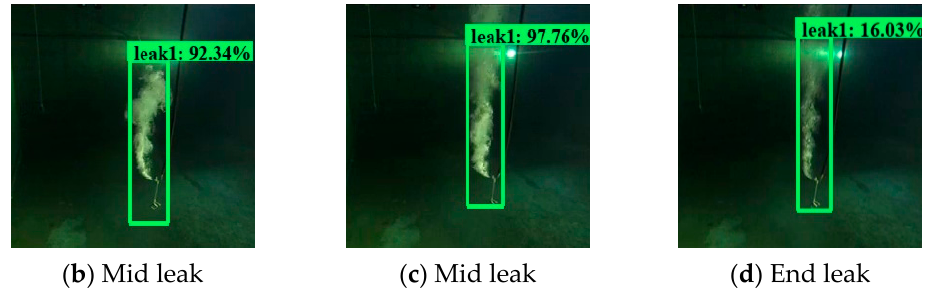
Figure 18. Visualization examples of the Faster R-CNN model developed by the image size 1280 × 720 dataset under the Co. L. Mar. dataset.